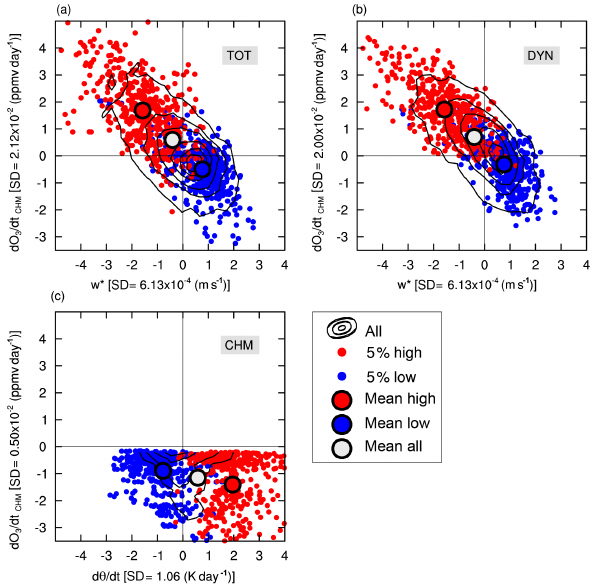
Figure 7. Same as Fig. 3, but from a 100-year CESM1(WACCM) simulation.